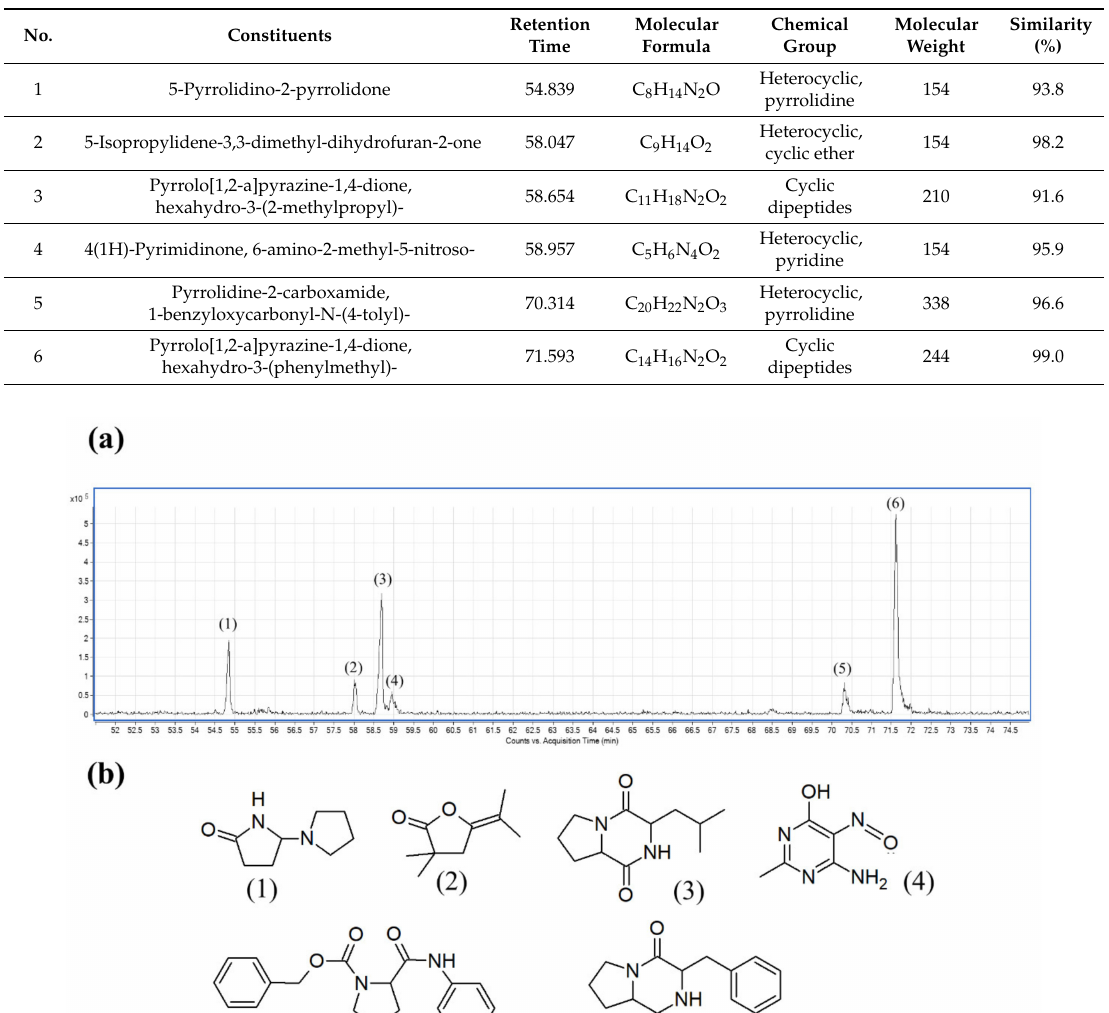
Table 1. Chemical constituents detected by GC-MS analysis.